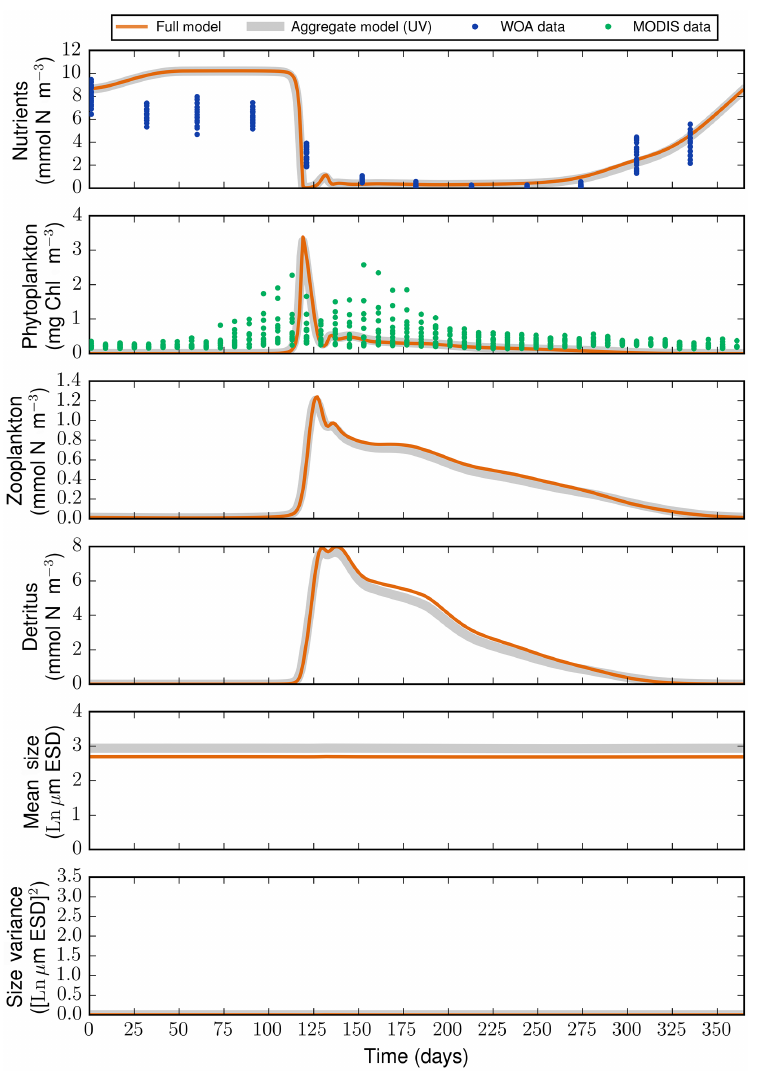
Figure 3. NPZD dynamics of the full model (Sect. 2.1.2) and of its equivalent aggregate model (Unsustained variance, Sect. 2.1.3) for the last year of the simulations. The total phytoplankton in the full model corresponds to the sum of all P n . The red dots are observations of nitrogen concentrations (monthly data obtained from the World Ocean Atlas) and the green dots are remotely sensed Chl- a data (8-day composite obtained from